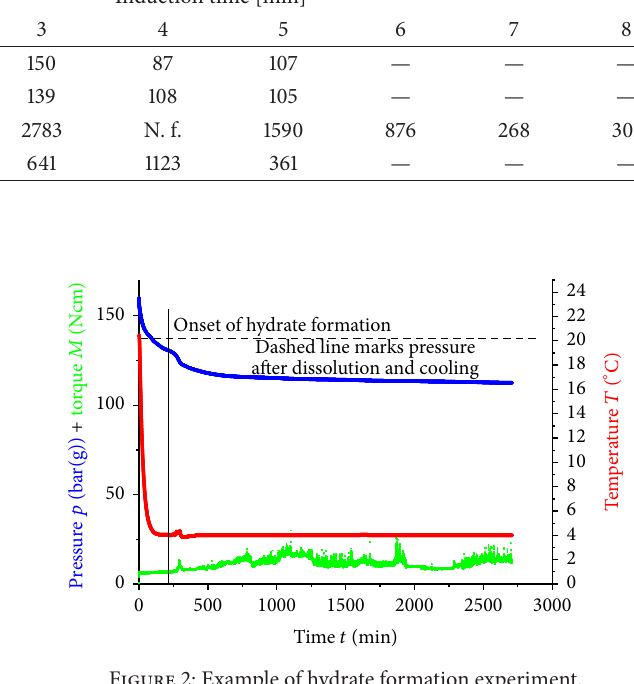
Figure 2: Example of hydrate formation